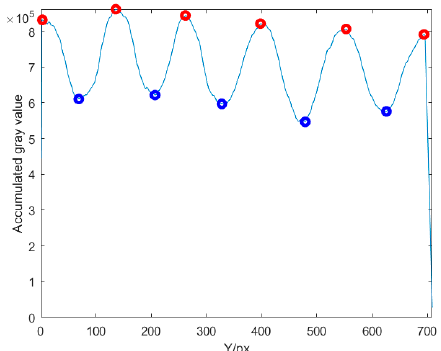
Figure 2. Row and column detection with multimodal data of orchard canopy.